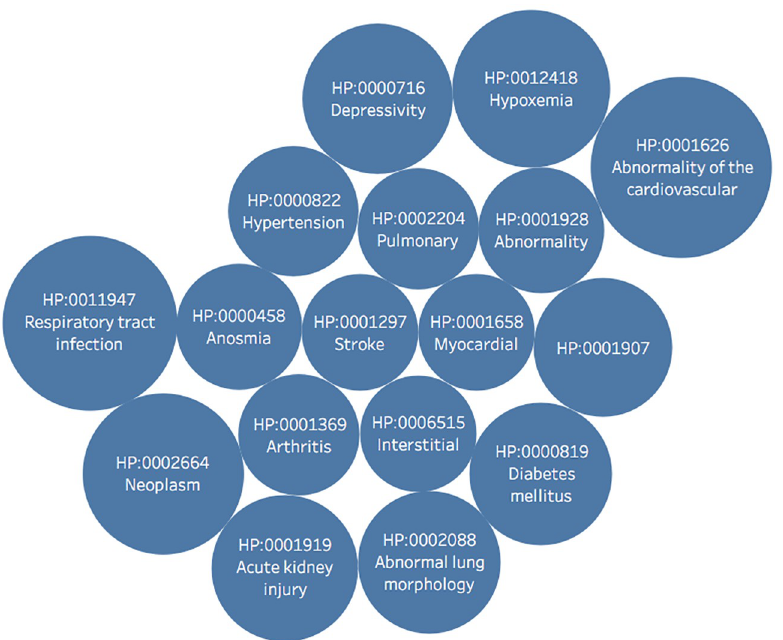
Fig 8. HPO information portrays the most widely noted HPO terms. Note that HPO terms are normalized as detailed in Alag 2020 [6]. The most frequent terms were Respiratory tract infection, Abnormality of the cardiovascular system, Acute kidney injury, Abnormal lung morphology, Depressivity, Diabetes mellitus, and